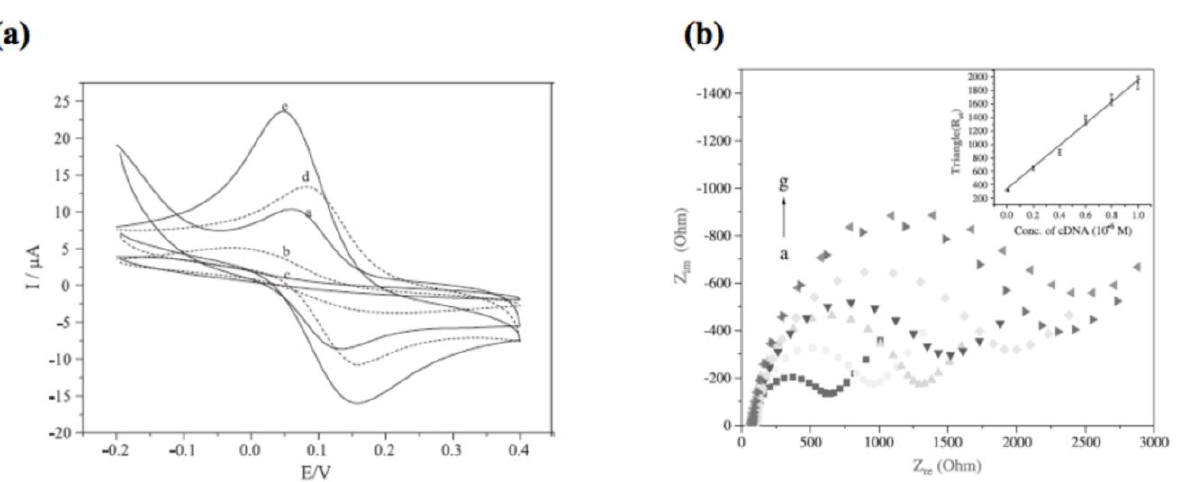
Figure 11. Examples for a measurement curve of cyclic voltammetry (CV) ( a ) and electrochemical impedance spectroscopy (EIS) ( b ). The adsorption of molecules to the surface can be seen from a decrease in current (CV) and an increase in impedance (EIS). Reproduced from [101] with permission from